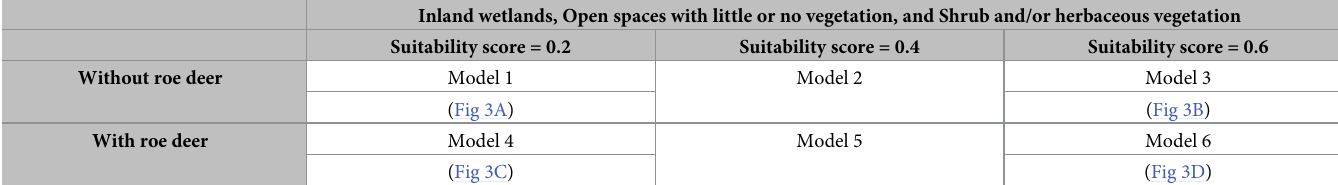
Table 4. Versions of land cover dataset and prey density dataset used in each model. Inland wetlands, Open spaces with little or no vegetation, and Shrub and/or herbaceous vegetation Suitability score =